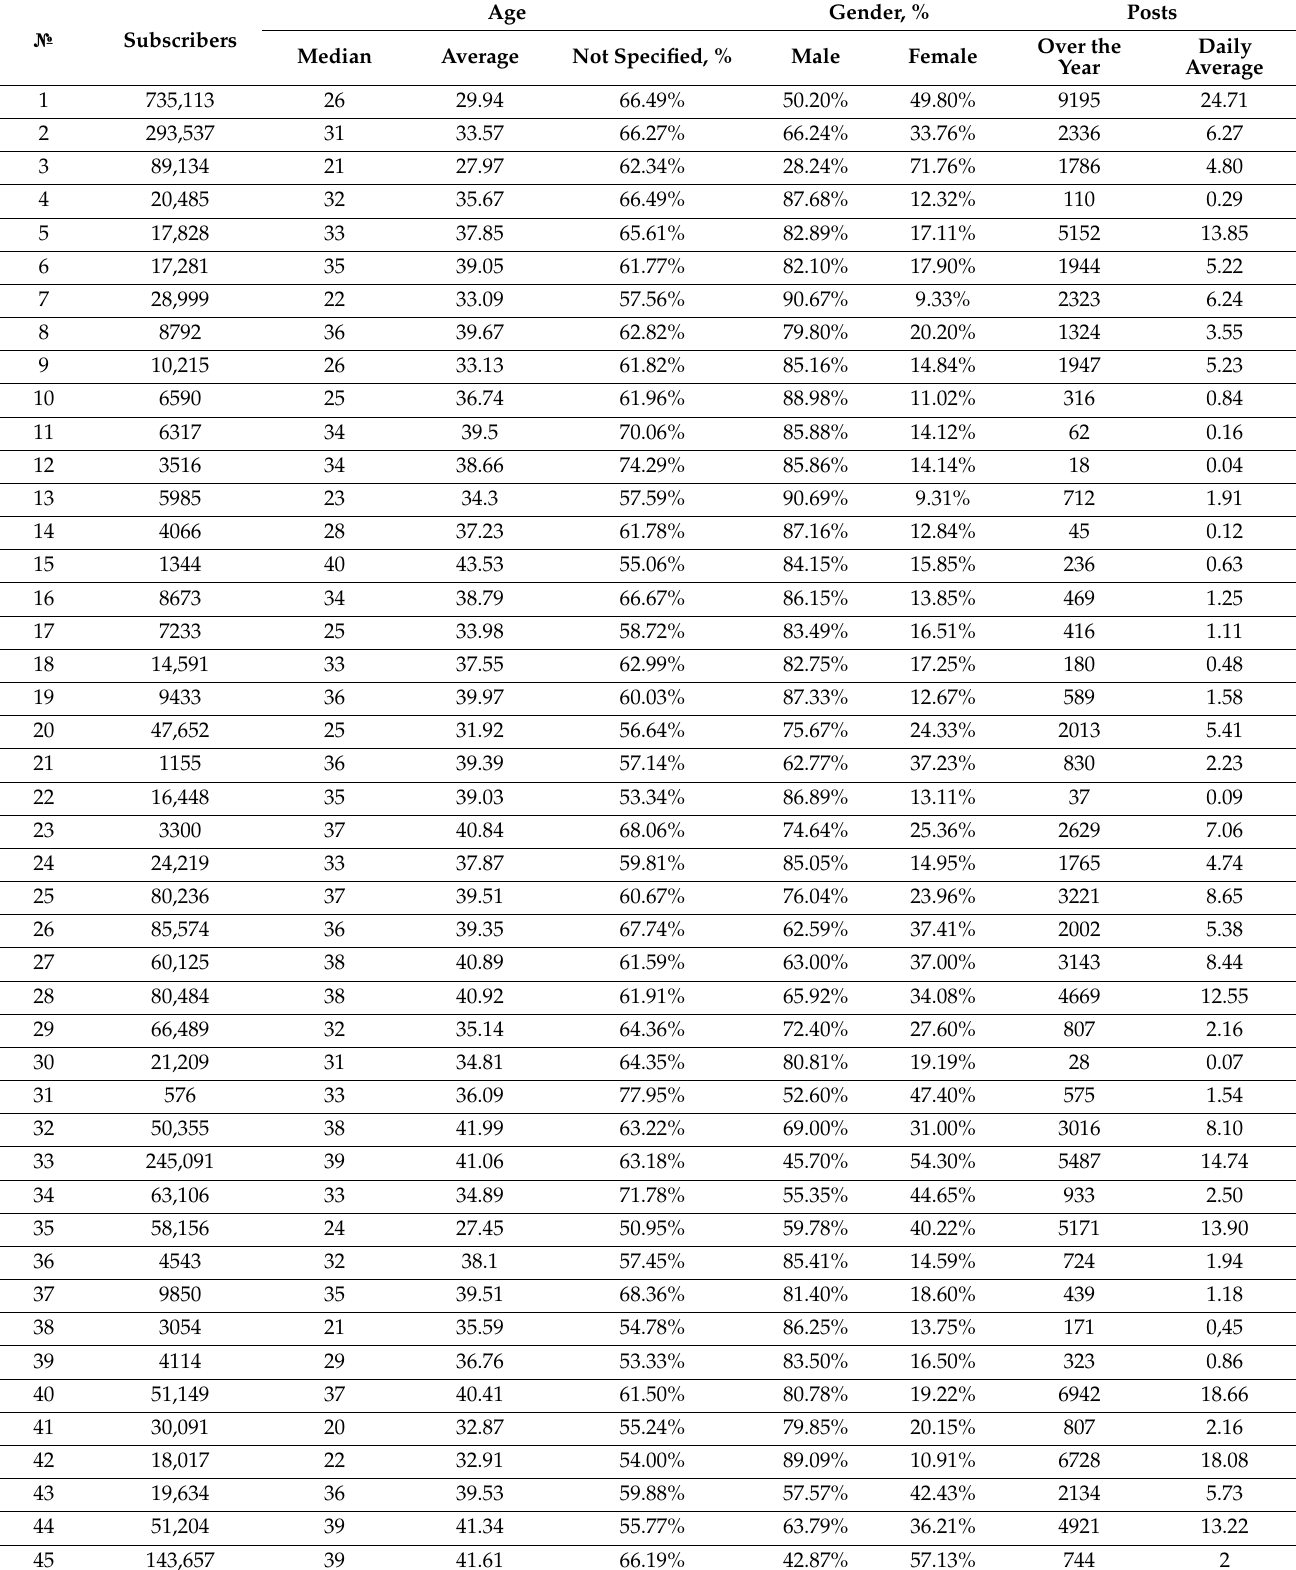
Table 2. Background information on the communities detected by the